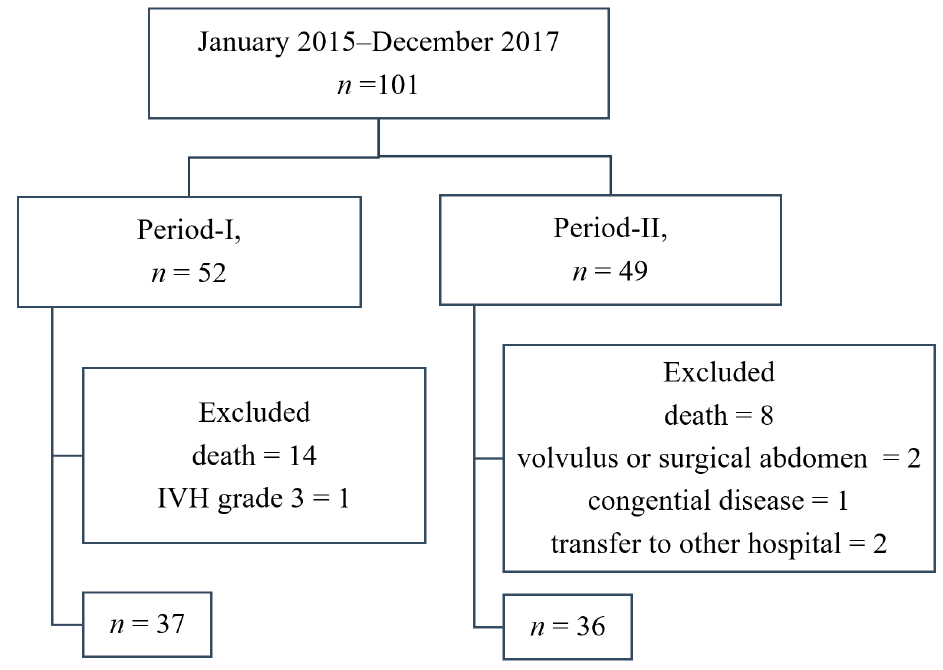
Figure 2. Flowchart of the study periods and participants. IVH: intraventricular hemorrhages. The demographics, perinatal complications, and neonatal complications of the infants in Period-I and Period-II groups are listed in Table 2. Infants in both groups were comparable in gestational age, gender, multiple pregnancies, small for the gestational age, body weight, body